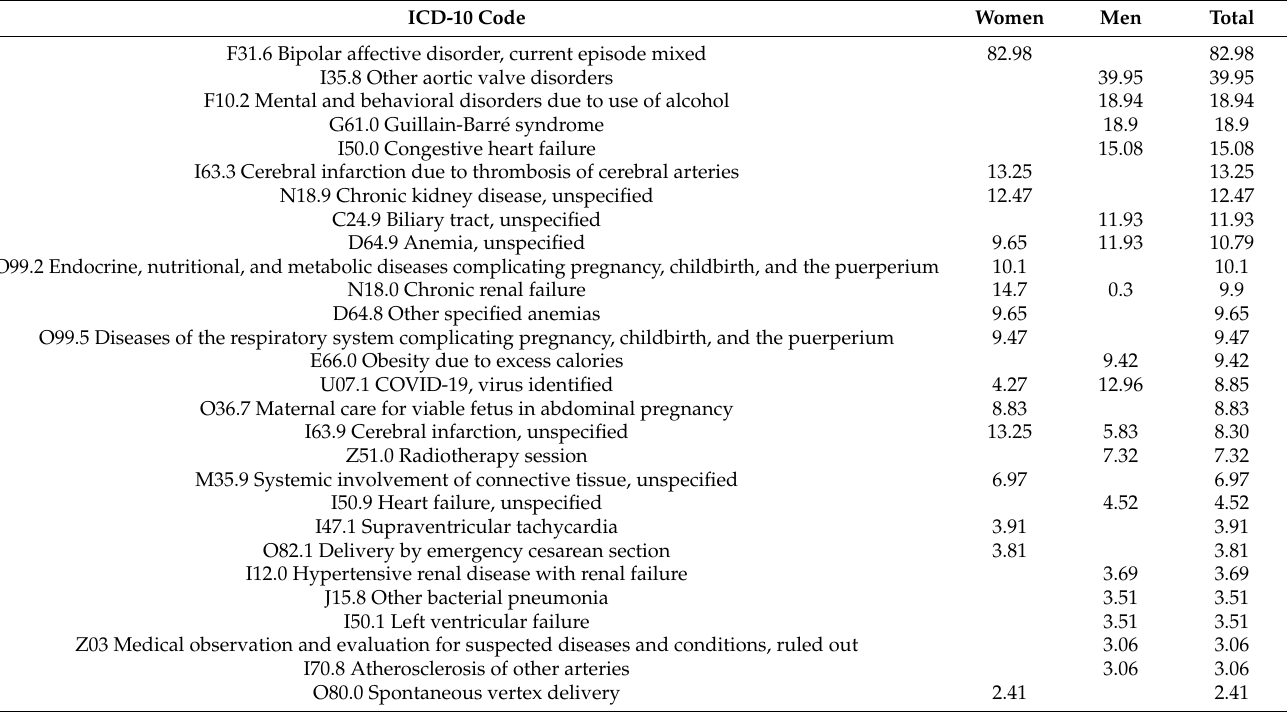
Table 6. Average time of hospitalization in